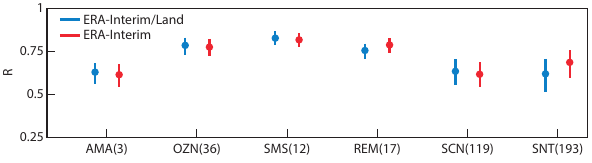
Figure 10. Correlation with observed ISMN soil moisture networks (as in Table 2) for ERA-Interim/Land (blue) and ERA-Interim (red). Only significant correlations with p values < 0.05 are considered and for each of the observing networks the bars indicate the 95% confidence interval calculated using a Fisher Z transform.